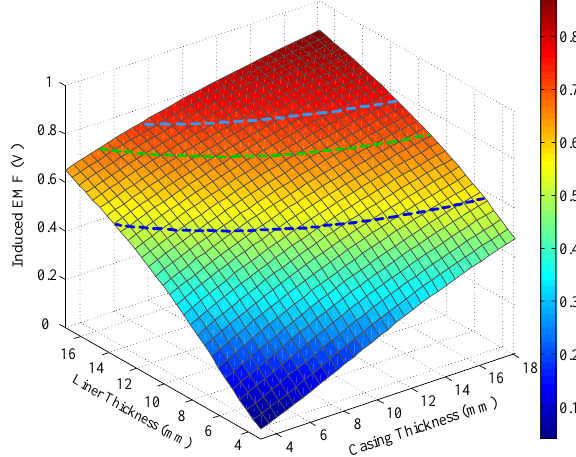
Figure 10. Induced EMF in the auxiliary sensor at 30 ms.